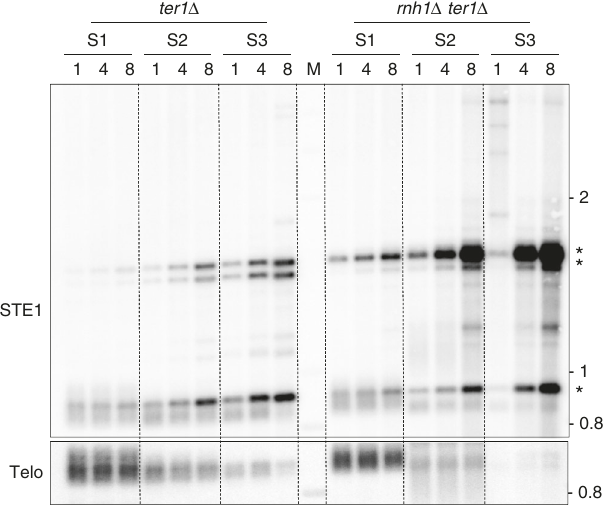
Fig. 7 RNA:DNA hybrids promote STEEx formation. Replicative senescence (S1 – S3) was carried out with ter1 Δ and rnh1 Δ ter1 Δ cells by successive streakings on YES agar plate. Then cells were grown in minimal medium and shifted to deprived-nitrogen medium. ter1 Δ and rnh1 Δ ter1 Δ cells were collected after the indicated days (1, 4, and 8) in quiescence. Genomic DNAs were digested with EcoR I and analyzed by southern blot with a Telo and STE1 probes. STEEx are shown by